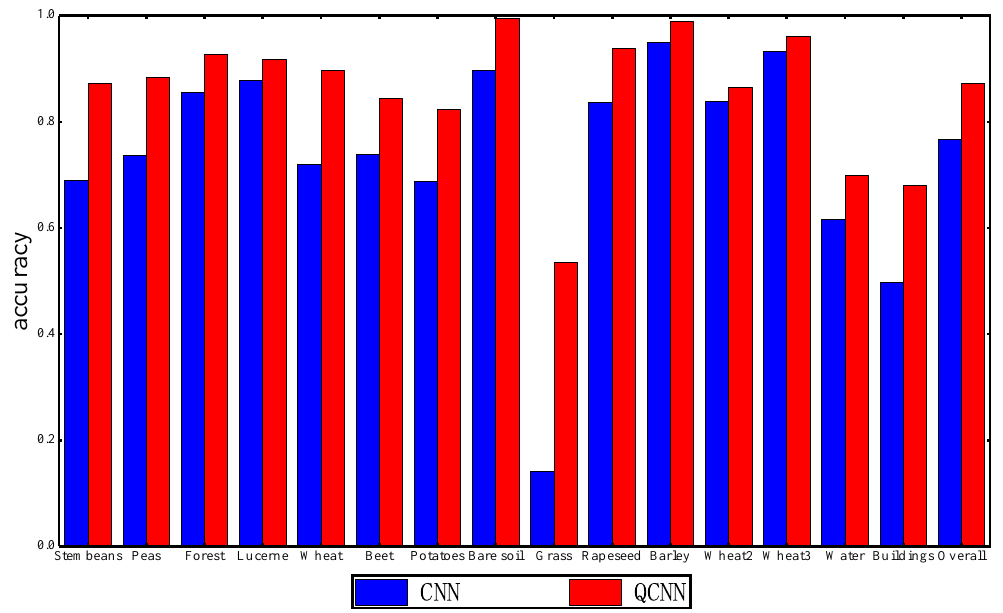
Figure 13. The classification accuracies by CNN and QCNN on Flevoland data